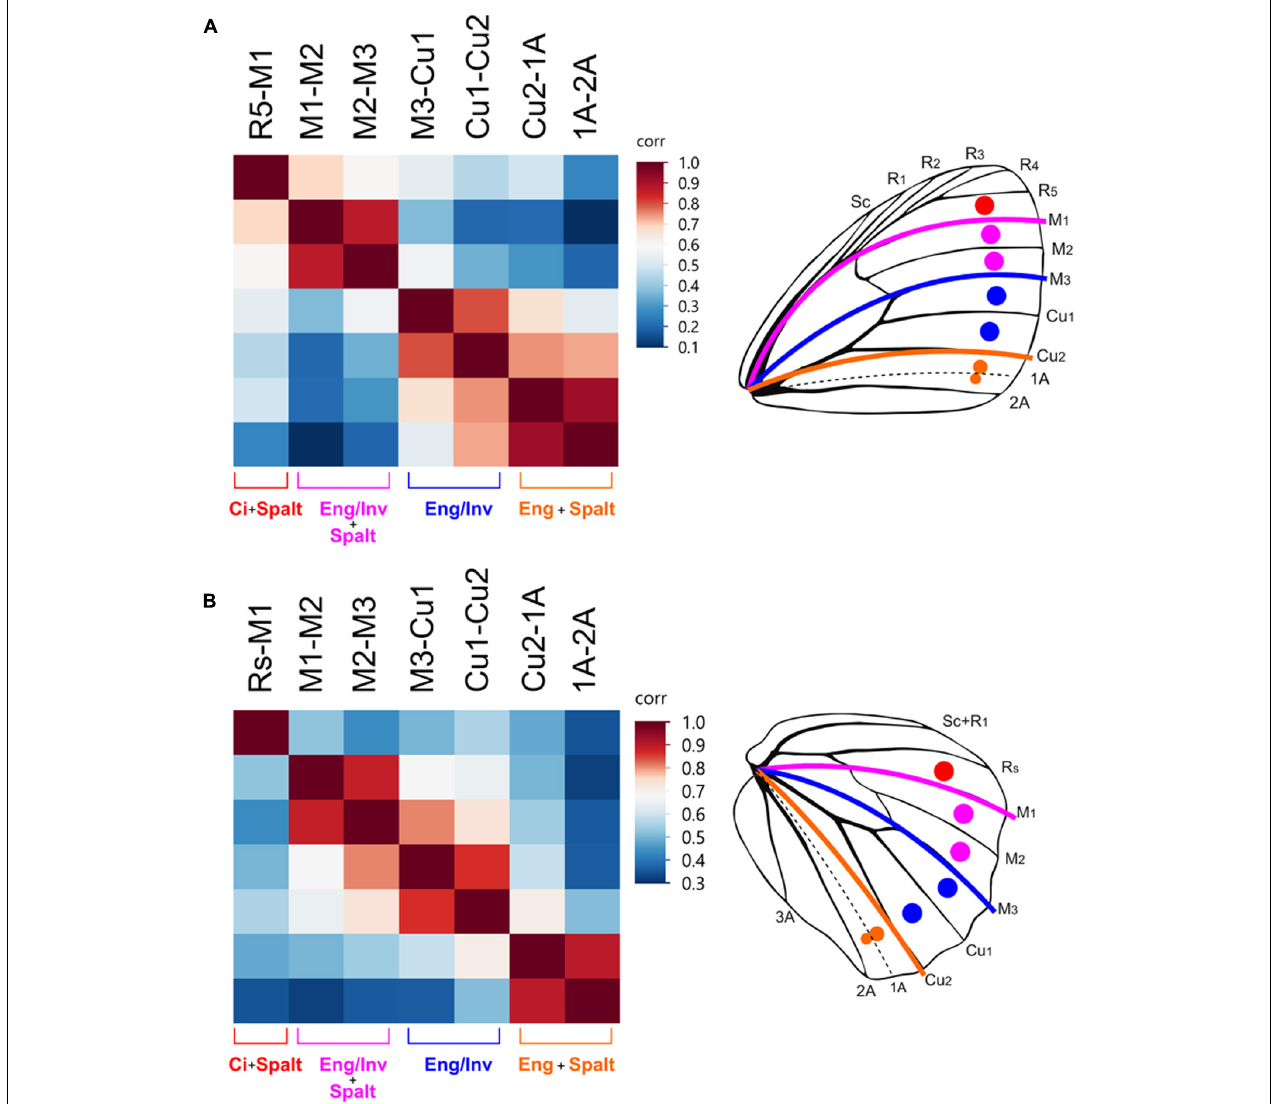
FIGURE 5 | Border ocelli placement is modular and maps to the AP expression domains. Heatmaps of correlations between the relative distance from the wing margin of border ocelli in Satyridae and Nymphalidae. Dark red colors indicate strong correlations. Light red, white, and blue represent weaker correlations. In the forewing (A) and hindwing (B) , ocelli within each expression domain are strongly correlated with each other and are weakly correlated with ocelli in other expression domains.